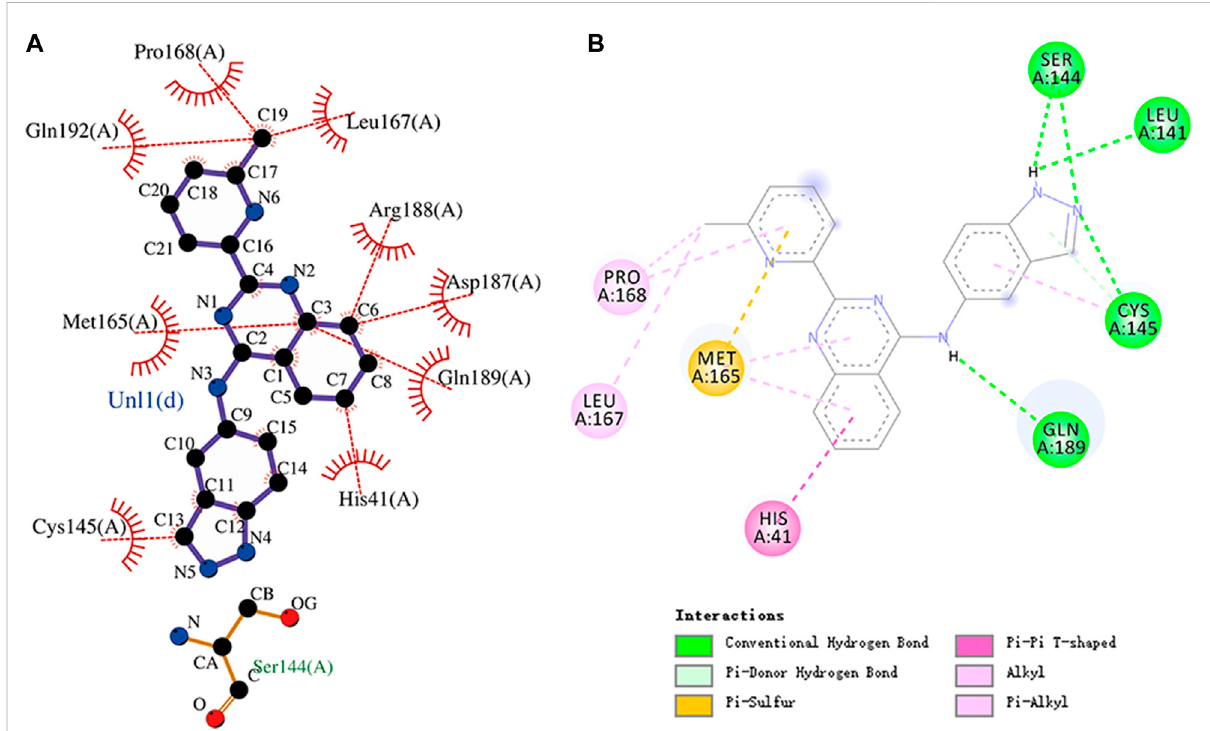
FIGURE 9 (A) Hydrophobic interaction between M pro and N-1H-indazol-5-yl-2-(6-methylpyridin-2-yl)quinazolin-4-amine and (B) two-dimensional plot